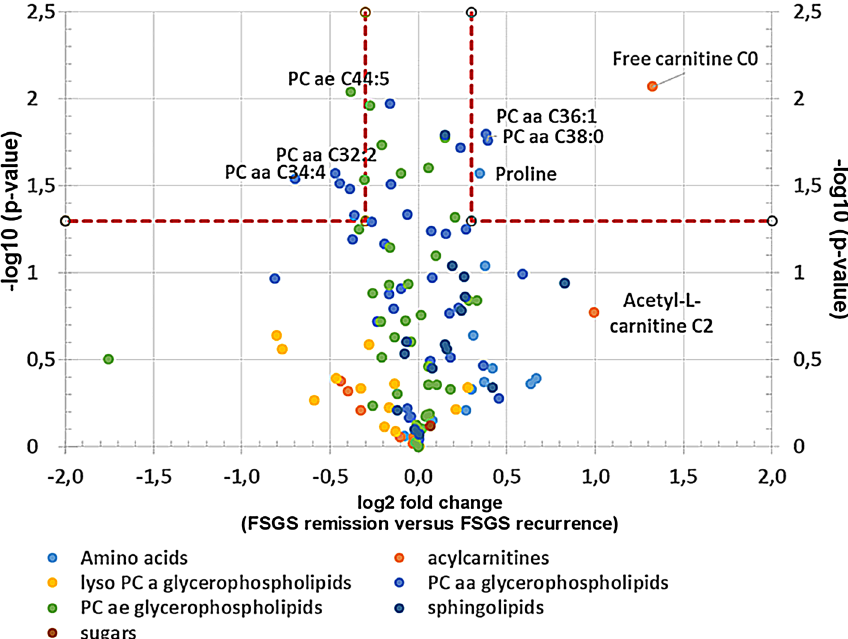
Figure 6. Serum metabolome analysis of recurrent FSGS reveals changes in carnitine and phosphatidylcholine- levels. Volcano-Plot of the serum metabolome analysis of the patient with FSGS. Log2 fold change of metabolites at FSGS remission versus FSGS recurrence as well as –log10 (p-values) are given. PCaaC34:4 and l-carnitine were significantly altered at remission versus recurrence. Confidence limits (fold change > 0.3, p-value < 0.05) are shown with dashed lines. Metabolomics are labeled in different colors according to their metabolomics class.